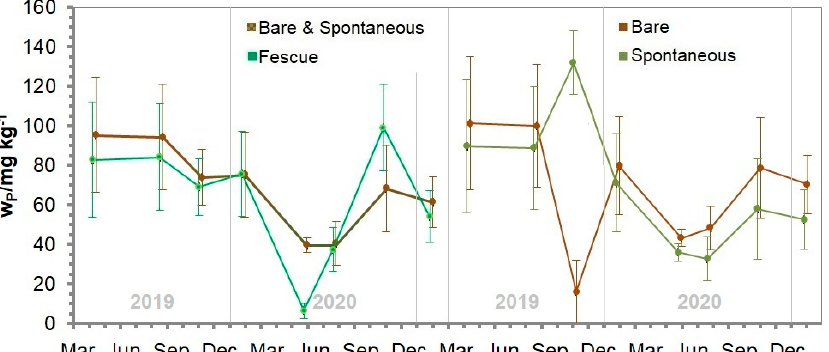
Figure 11. Soil available phosphorus ( w P ) at 0–20 cm in the different treatments throughout eight sampling dates during the monitoring time alongside the respective 95% confidence intervals according to the orthogonal contrasts based on the one-way ANOVAs results.